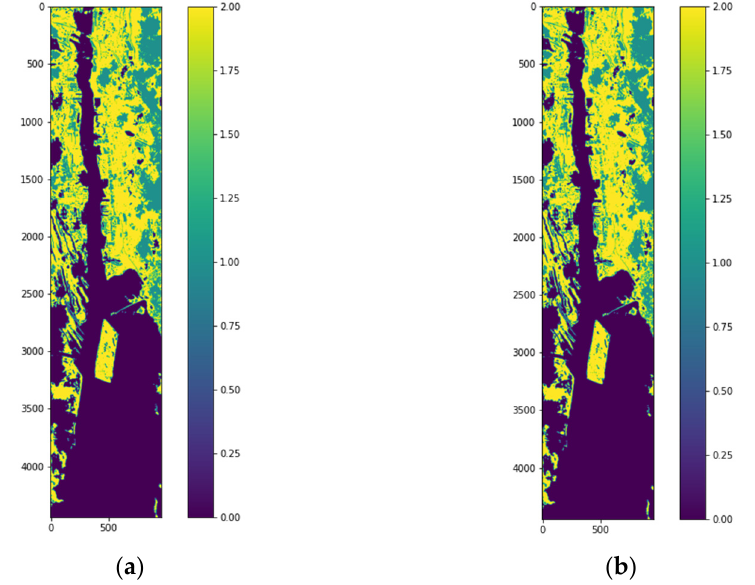
Figure 11. ( a ) HIS2 Image 2 with labels for 3 classes using the unsupervised stage (k-means clustering method), ( b ) Reconstructed image from classified samples using the supervised stage.